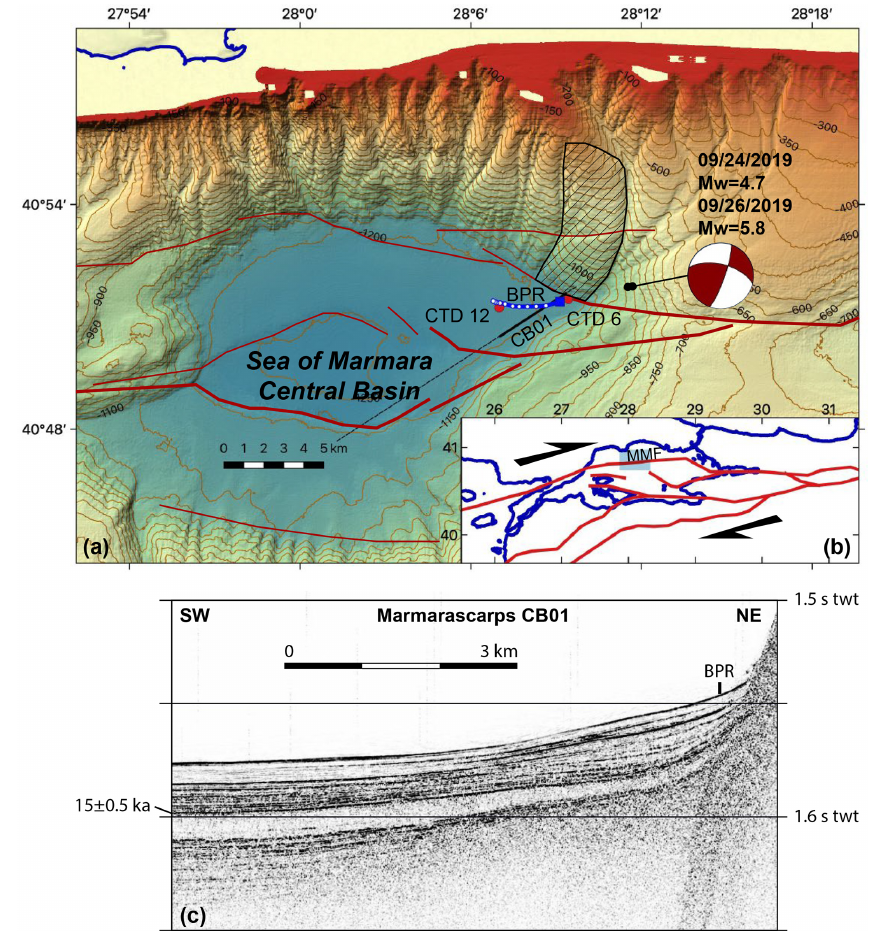
Figure 1. Context of instrumental deployment. (a) Bathymetric map of the Sea of Marmara Central Basin with simplified fault geometry (in red). The hatched zone is a suspected mass-wasting zone (Zitter et al., 2012). Location of instrumented frame comprising bottom pressure recorder (BPR) and Doppler current meter is indicated by blue square. The blue banana-shaped line with white dots represents the calculated trajectory of a sedimentary particle during the waning phase of the turbidity current. Red dots are conductivity–temperature–depth (CTD) profiles 6 and 12 shown in Fig. S1. Epicenter location of earthquakes and the focal mechanism of the main shock are indicated. (b) Location of study area. North Anatolian Fault system is shown in red. MMF is the Main Marmara Fault. (c) Sediment sounder profile from Marmaras- carps cruise (Armijo and Malavieille, 2002). Indicative age of reflector from Beck et al. (2007). The instrument (BPR) was deployed on a depositional fan at the base of slope and canyon outlet that differ in seismic character from the reflector sequence in the